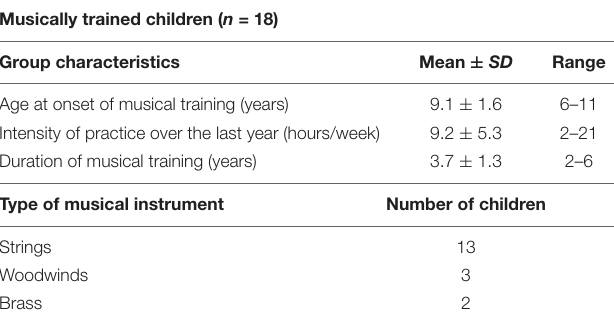
TABLE 2 | Characteristics of musical training in musically trained